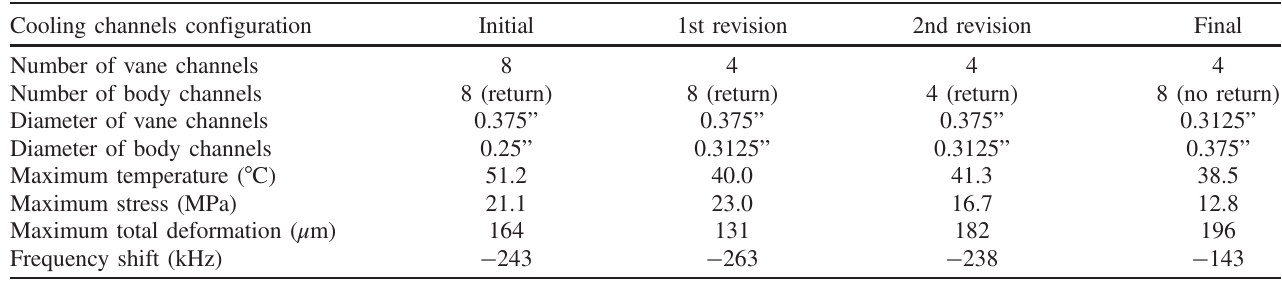
TABLE V. Iterations of cooling channels configuration and corresponding results.